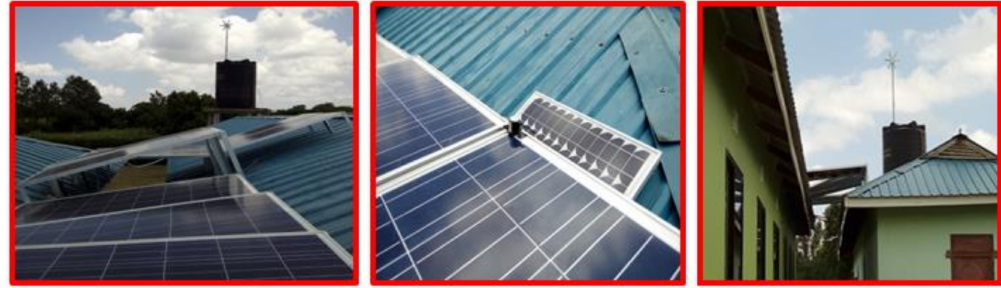
Figure 16. A prototype of off-grid hybrid CLC-SS-Wind HES at installed Mbuguni.